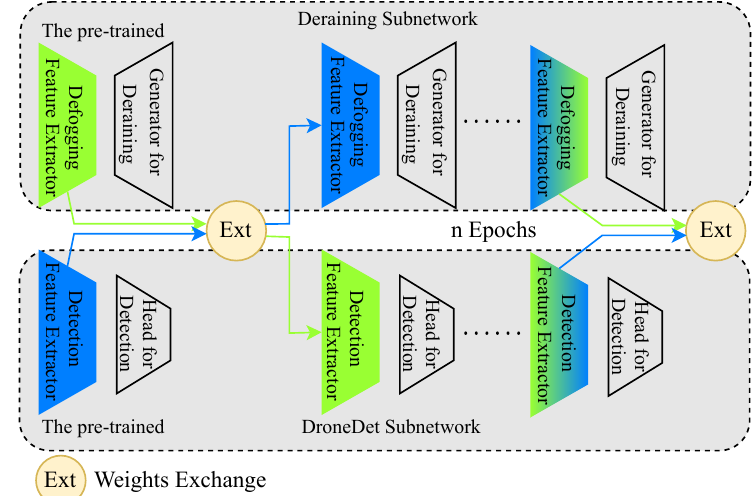
Figure 4. The process of our ColTeaching.